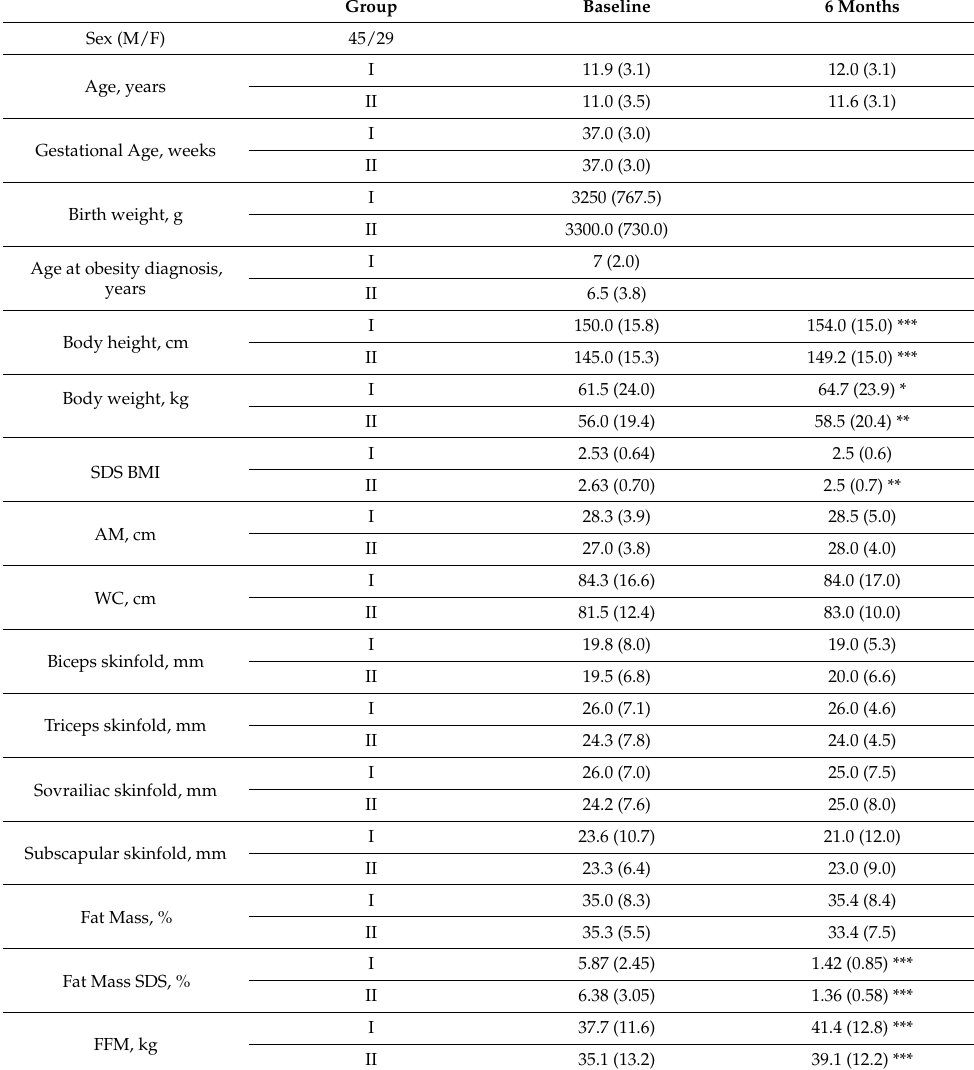
Table 1. Clinical and anthropometric variables in D + DHA group and vitamin D group after 6 months from the start of the study. Data are expressed as median (IQR).